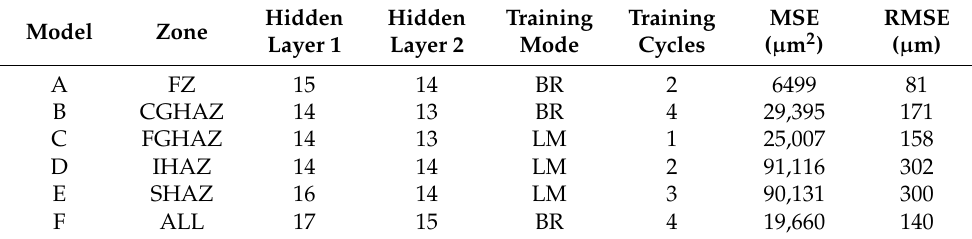
Table 7. Measurements corresponding to sample 1.